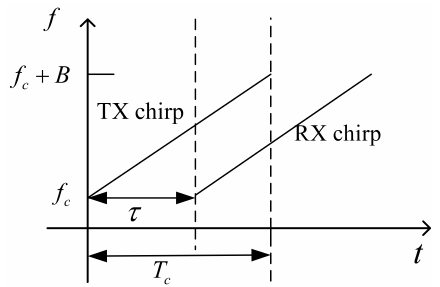
Figure 2. FMCW radar echo diagram.